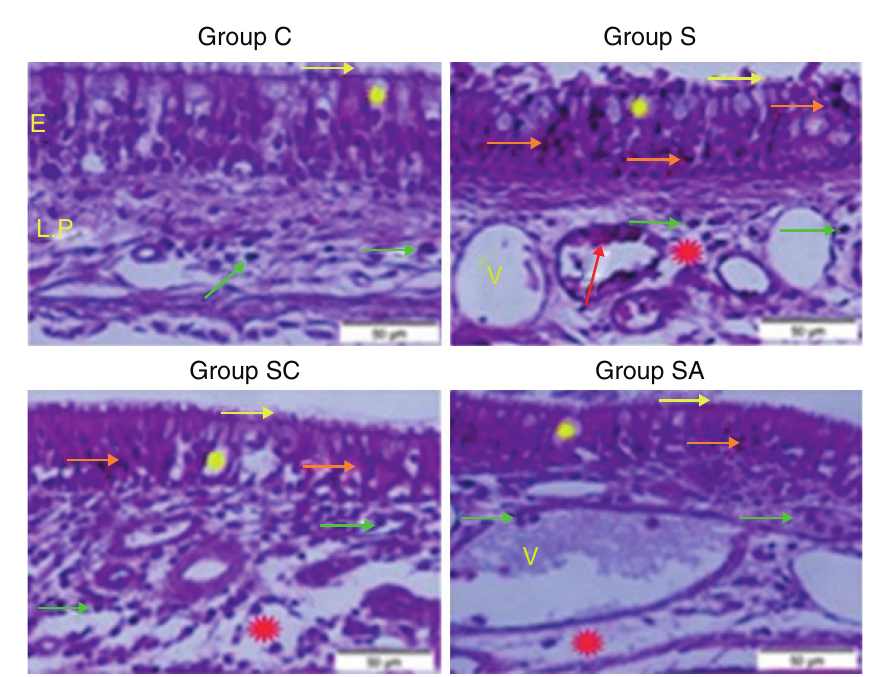
Figure 1 Micrograph of tissues for all groups. E, Epithelium; LP, Lamina Propria; V, Vasodilatations in veins, yellow star; goblet cell, red star; lamina propria edema, green arrow; neutrophiles, red arrow; macrophages, orange arrow; degenerative epithelium cell, yellow arrow; cilias, H&E